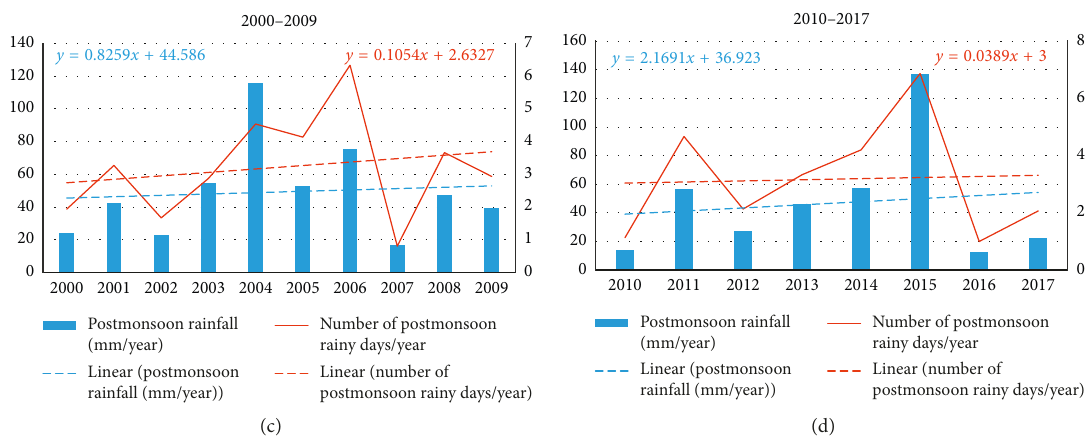
Figure 9: The number of rainy days during postmonsoon depicts an increase in almost all